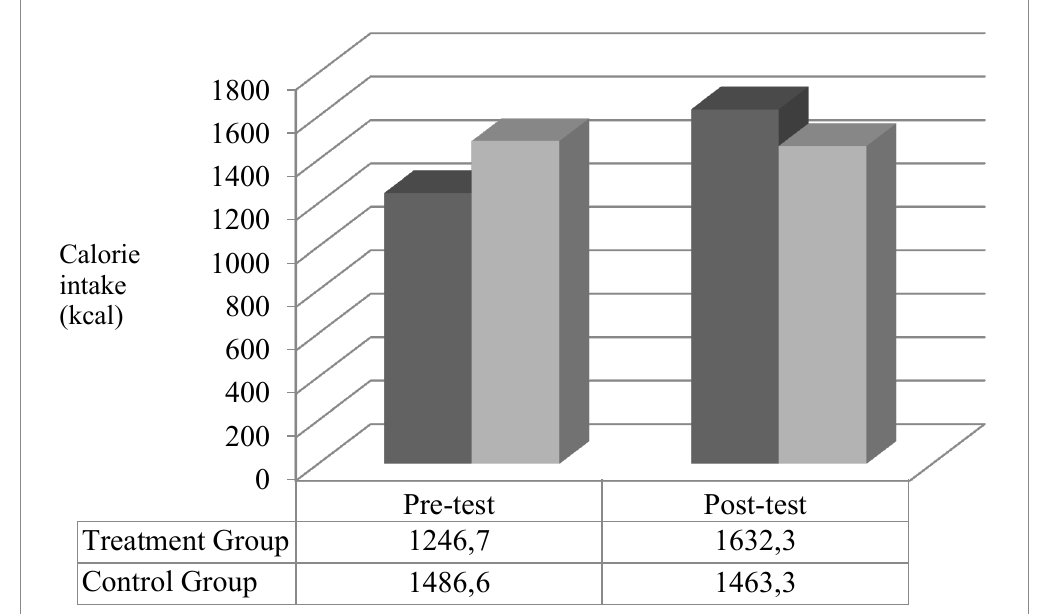
Figure 1. Subjects’ energy intake before and after the intervention in the treatment and control groups.